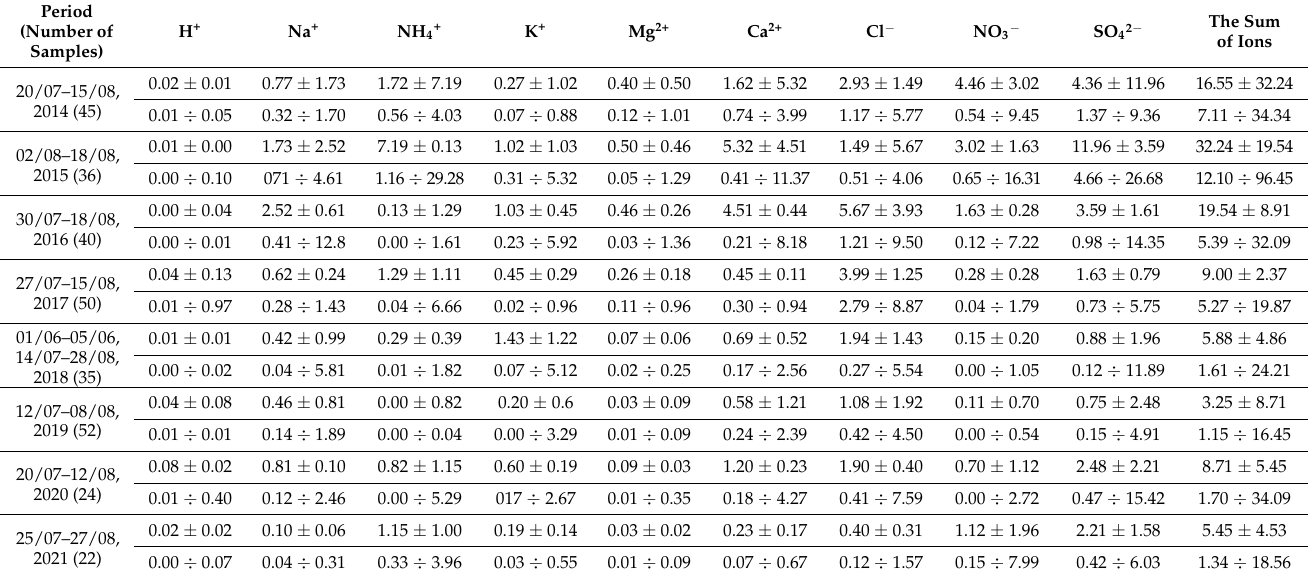
Table 5. Ionic composition of the atmospheric aerosol at the Boyarsky research station from 2014 to 2021, µ g/m 3 (the upper line shows the arithmetic mean ± standard deviation; the lower line shows the